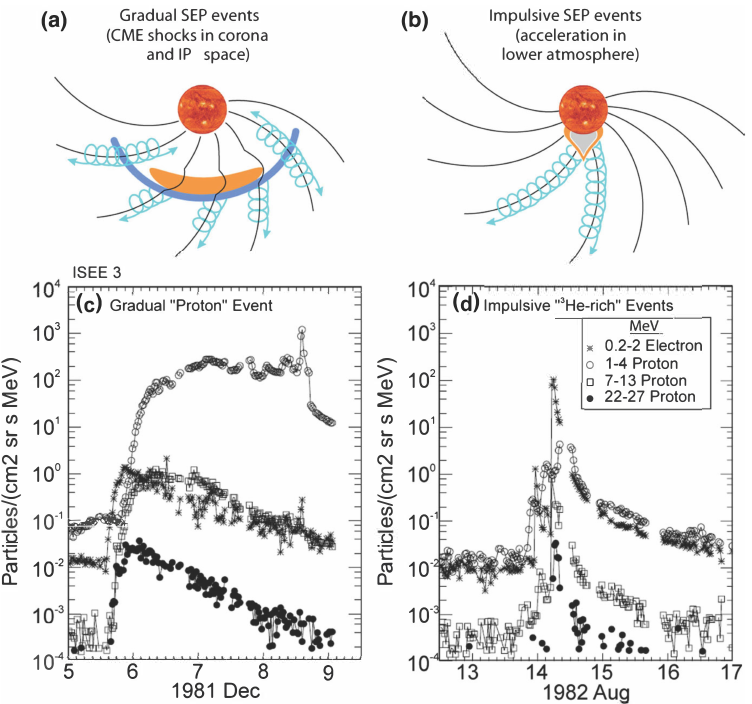
Figure 1. Gradual and impulsive SEP events, adapted from [5,9]. ( a )—gradual events produced by the acceleration driven by coronal mass injection (CME) shock wave, ( b )—impulsive events produced by a solar flare. ( c , d )—flux profiles of different particles (protons and electrons) for the two types of SEP events